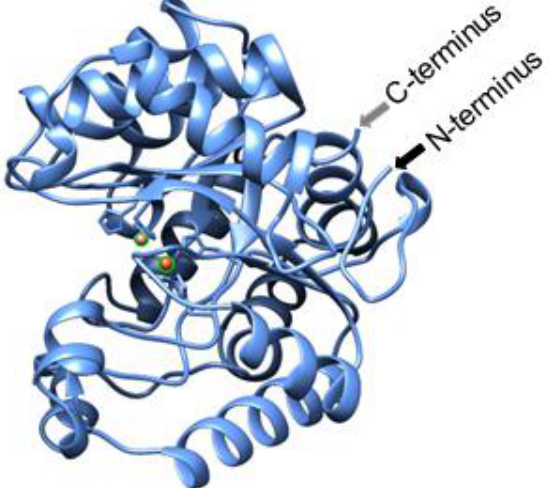
Figure 1. Cartoon of Sso Pox. This cartoon, generated using the Expasy Swiss-model (www.expasy.org) and then visualized using UCSF Chimera (www.cgl.ucsf.edu) with the same sequence as 2VC5, illustrates the orientation of the N- and C-termini as well as highlights the cobalt ions shown as orange balls at the location of the active site.